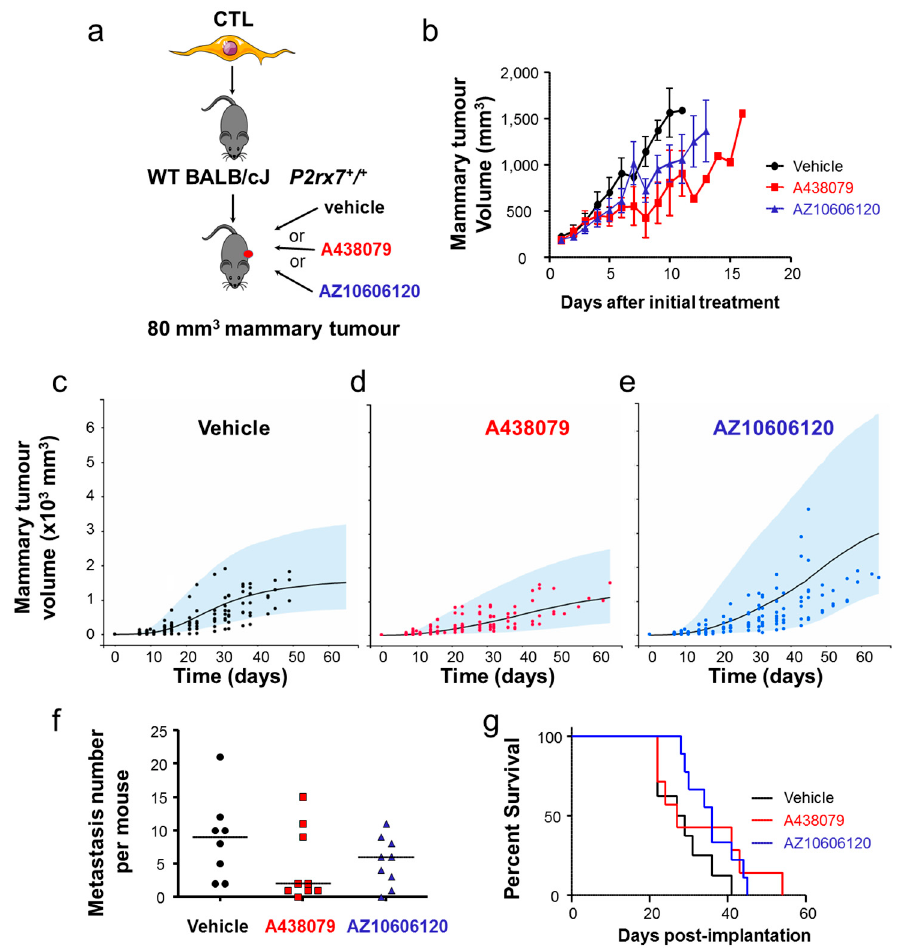
Figure 5. P2X7 antagonism slows mammary tumour growth. ( a ) In vivo mouse experiments assessing the effects of treatments with two P2X7 antagonist (A438079 or AZ10606120) on primary tumour growth, in which cancer cells and host organisms both express the P2rx7 gene. ( b ) primary mammary tumour growth represented as a function of the duration of the treatment depending on antagonist treatments (A438079 or AZ10606120) compared to the injection of vehicle. ( c–e ) A Gompertz model was used to assess mammary tumour growth as a function of time for ( c ), vehicle group, ( d ), A438079 and ( e ), AZ10606120. Black, red and blue dots represent individual tumour volumes of these respective categories, blue areas are 90% model prediction intervals and lines are the median tumour growth. Estimated mean (inter-individual standard deviation) of model parameters were k growth = 0.64 day-1 (39%), V max = 1.620 mm 3 (64%), EFF = 0.52 (82%) and γ = 0.17 (–). This analysis showed that